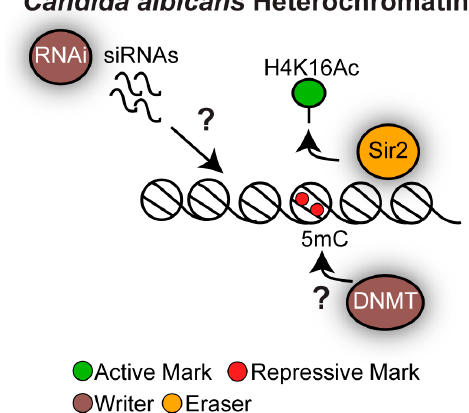
Figure 6. Heterochromatin structure in Candida albicans . The NAD + - dependent histone deacetylase Sir2 maintains the hypoacetylated histone states. Repetitive elements are decorated by 5mC DNA methylation by an unknown DNA methyltransferase. It is unknown whether the RNAi machinery contributes to heterochromatin formation.